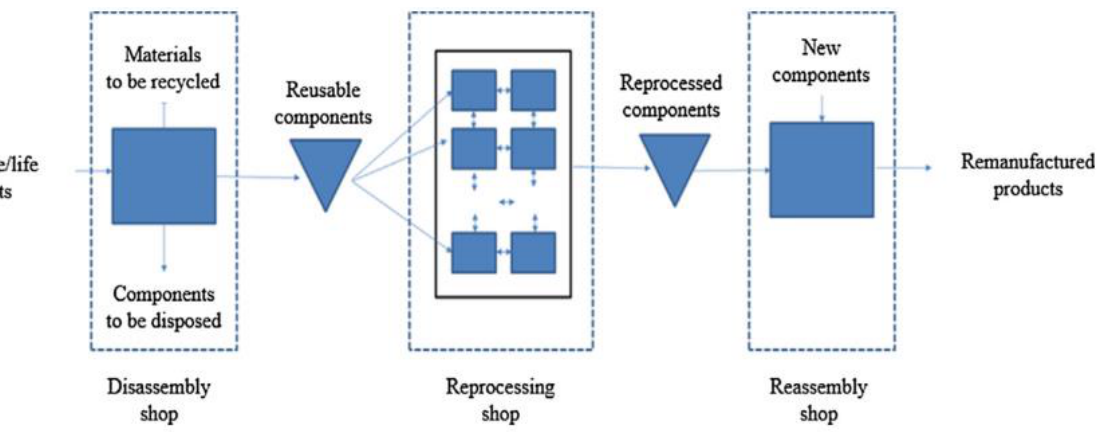
Figure 4. Composition of a typical remanufacturing system.